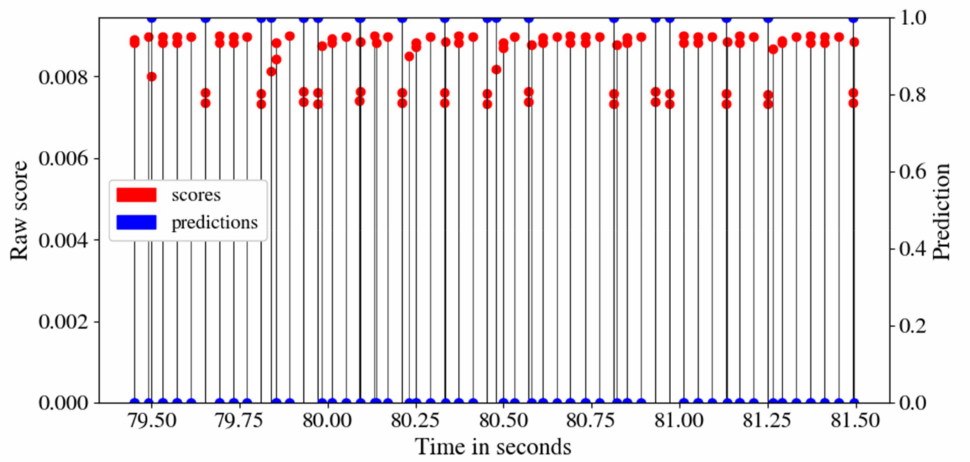
Figure 11. OC-SVM Predictions and raw scores of the anomaly-based NIDS for a corrupted PMU